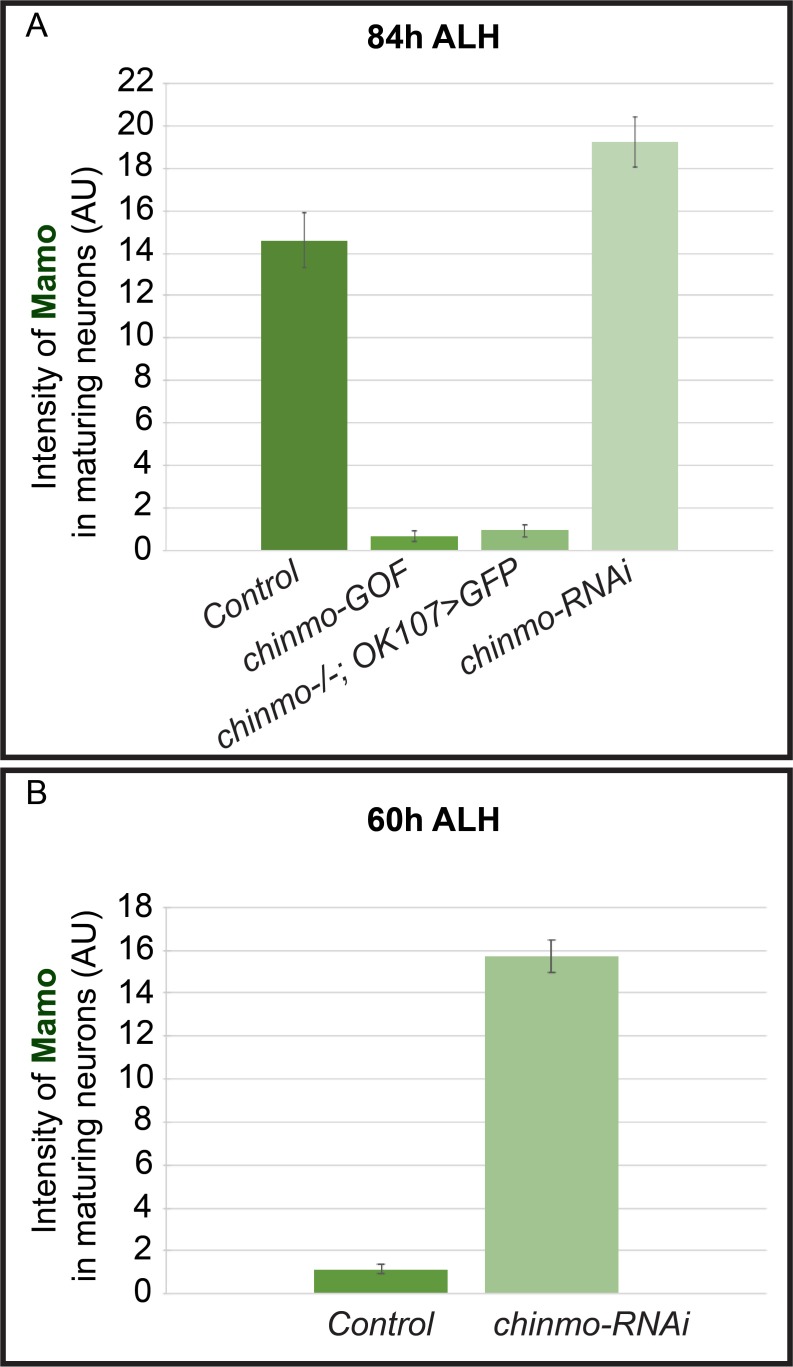
The intensity quantification of Mamo staining in different manipulations of MB neurons.(A–B) The intensity of Mamo (Green line) staining in MB neurons at 84 hr ALH (A) and 60 hr ALH (B). The Mamo levels were measured in the young/maturing neurons ﻿(mean ± SEM, n = 5–6 brains). AU, arbitrary fluorescent intensity units.